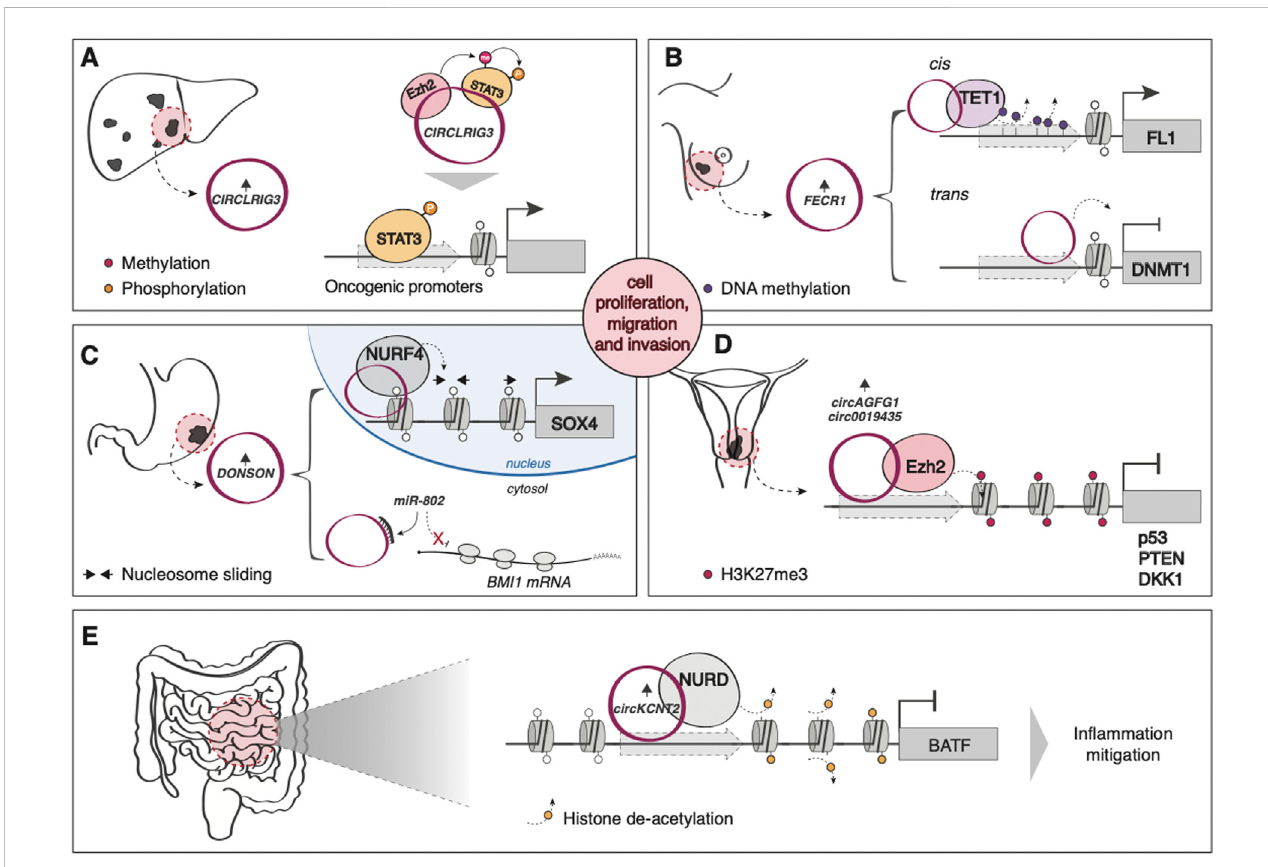
FIGURE 3 Examples of circRNA-mediated epigenetic regulation of gene expression (A) In hepatocellular carcinoma (HCC), the upregulated circLRIG3 acts as a scaffold to promote the interaction between EZH2 and its substrate, STAT3. Methylated and, subsequently, phosphorylated STAT3 induces the expression of oncogenic gene targets. (B) In breast cancer, FECR1 simultaneously recruits TET1 (in cis) and represses DNMT1 (in trans)to decrease the methylation levels of theoncogeneFriendleukemiavirusintegration1(FLI1). (C) circRNA DONSON ,overexpressedingastriccancer,modulatesthelevelsofBMI1bysponging miR-802 in the cytoplasm while inducing the nuclear expression of SOX4 by directly recruiting NURF on its promoter. (D) circAGFG1 and circ0019435 are both overexpressed in cervical cancer and induce the EZH2-mediated silencing of oncosuppressors p53 and PTEN, and DKK1, respectively. (E) circKcnt2 is overexpresseduponintestinalin fl ammationandmitigatesthein fl ammatoryresponsethroughtherecruitmentofNuRDcomplexonthepromoterofthepro- in fl ammatory molecule